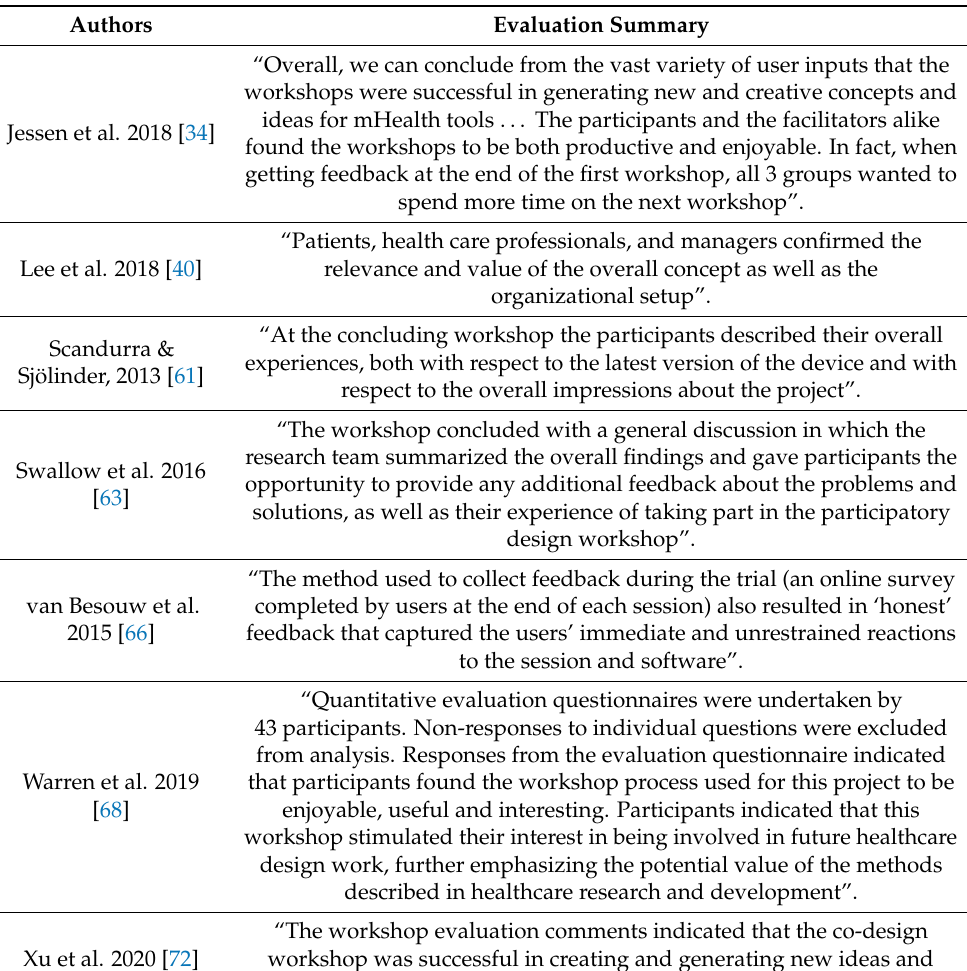
Table 2. Workshop evaluation